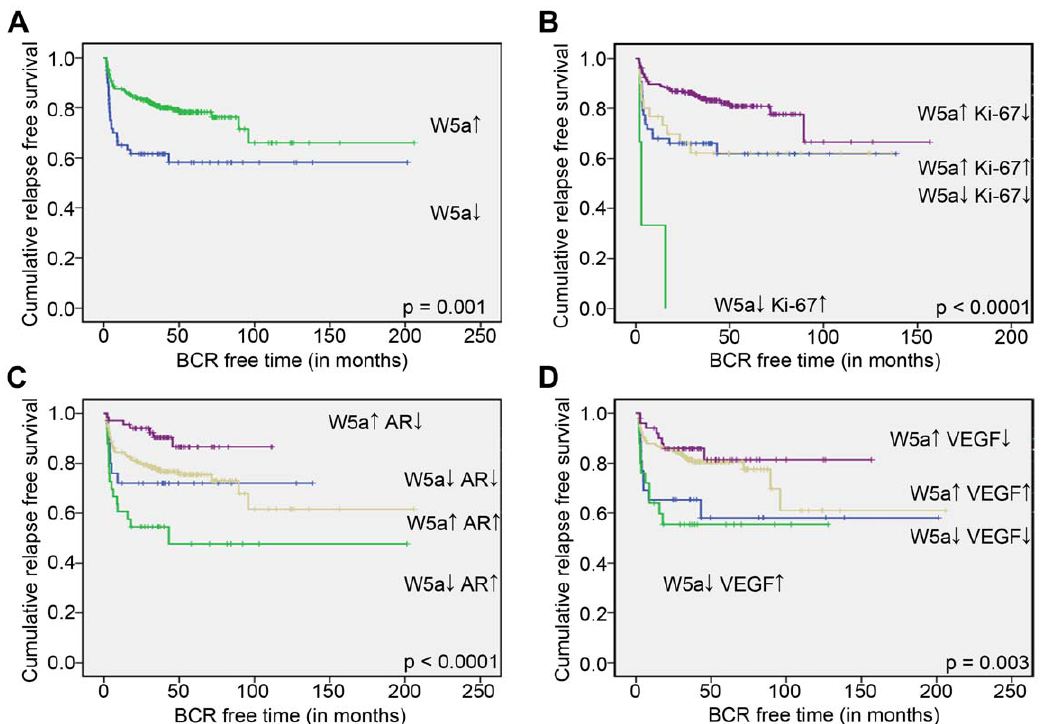
Figure 2. Analysis of how Wnt5a protein expression alone or in combination with other biomarkers affects the clinical outcome of PCa patients. All cancer cases were separated into 2 groups based on the staining intensities of Wnt5a, Ki-67, AR and VEGF. The low groups included tumors with scores 0 or 1 and the high groups included tumors with scores 2 or 3. A ) The panel shows survival curves plotted between high or low Wnt5a protein expression and BCR free time. B ) The panel shows survival curves plotted between high or low Wnt5a and high and low Ki-67 protein expressions. Consequently, the tumors were divided into the following 4 groups; Wnt5a low & Ki-67 low, Wnt5a low & Ki-67 high, Wnt5a high & Ki-67 low and Wnt5a high & Ki-67 high. C The panel shows survival curves plotted between high or low Wnt5a and high and low AR protein expressions. Consequently, the tumors were divided into the following 4 groups; Wnt5a low & AR low, Wnt5a low & AR high, Wnt5a high & AR low and Wnt5a high & AR high. D ) The panel shows survival curves plotted between high or low Wnt5a and high and low VEGF protein expressions. Consequently, the tumors were divided into the following 4 groups; Wnt5a low & VEGF low, Wnt5a low & VEGF high, Wnt5a high & VEGF low and Wnt5a high & VEGF high. In all panels high expression of a protein is indicated by q whereas Q indicates low expression. Each step in the curves represent relapse in PCa. The given p-values at the bottom right hand side of the panels indicate significant differences in outcome between the most favorable group and the least favorable group (see Table 4 for more detailed